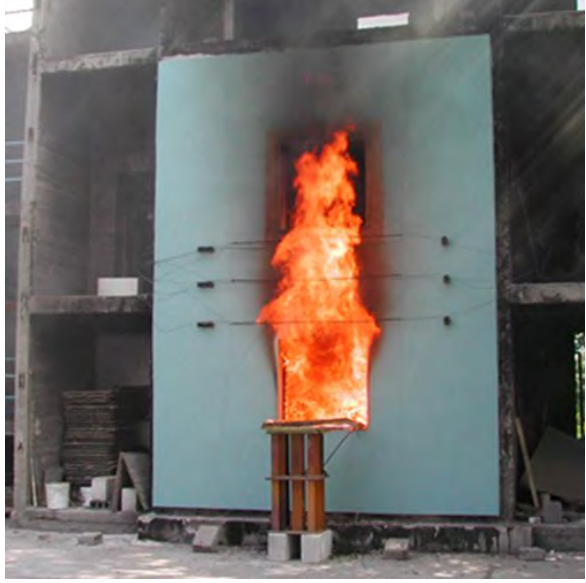
Figure 2: Example of fire test acc. to MSZ 14800-6:2009 procedure.